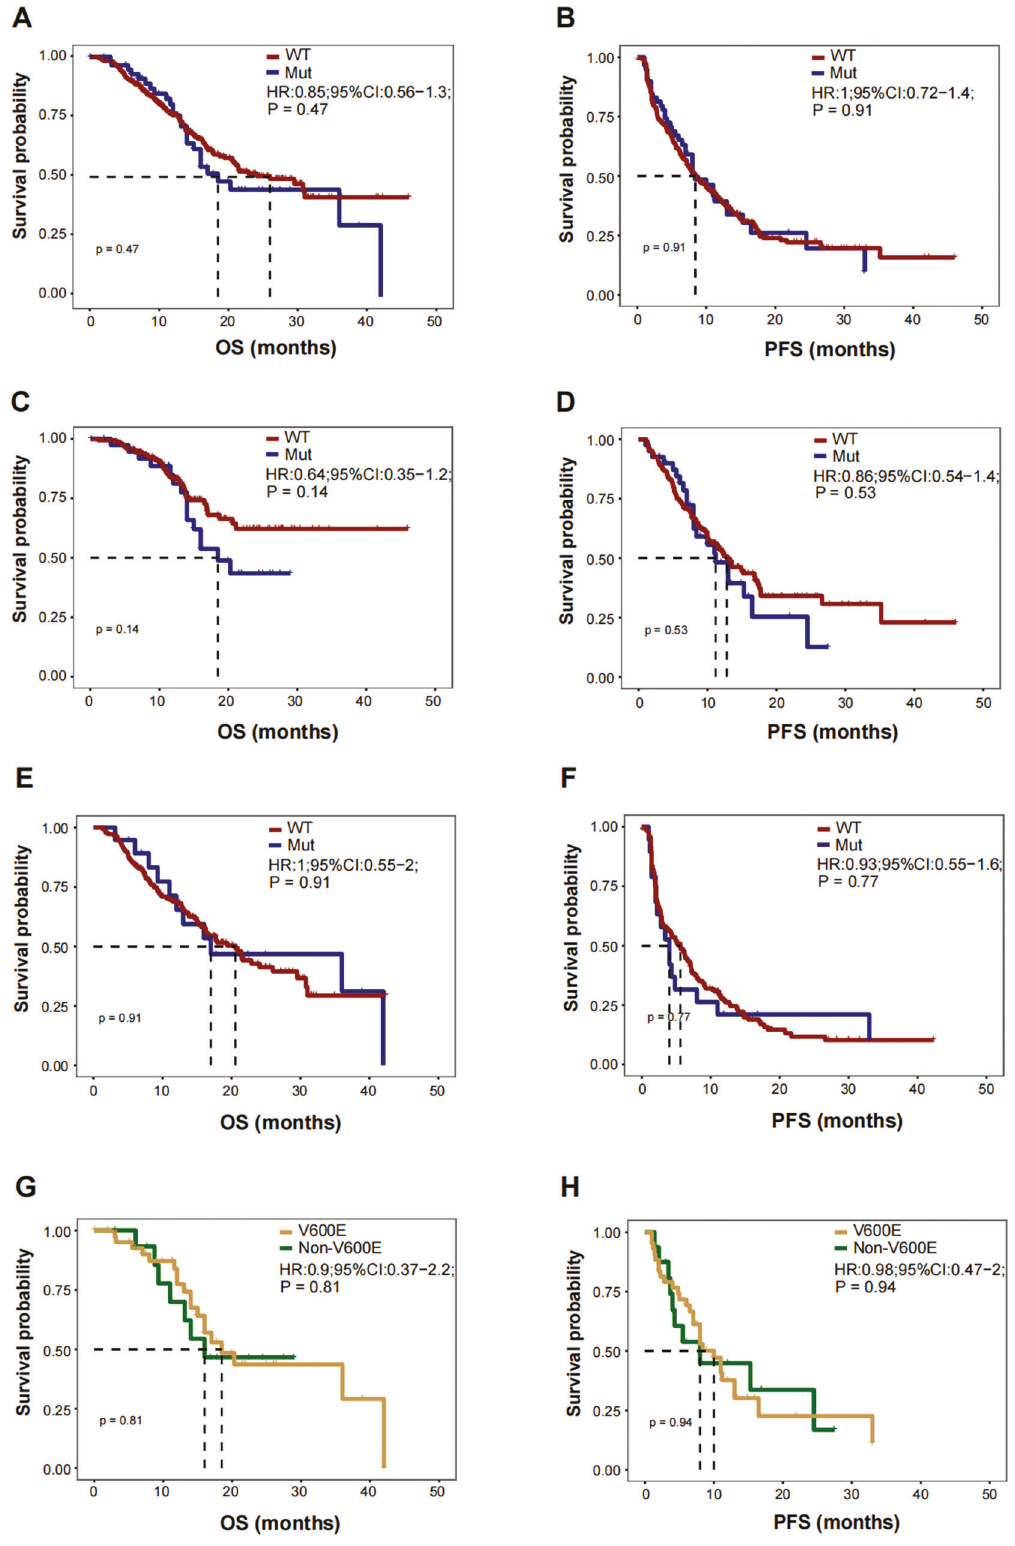
Fig. 6 Kaplan – Meier curves for progression-free survival and overall survival with ICIs monotherapy or ICIs combined therapy. A , B Overall survival ( A ) and progression-free survival ( B ) with ICIs or ICIs combined therapy according to the BRAF mutation status. C , D Overall survival ( C ) and progression-free survival ( D ) for fi rst line therapy according to the BRAF mutation status. E , F Overall survival ( E ) and progression-free survival ( F ) for second or later line therapy according to the BRAF mutation status. G , H Overall survival ( G ) and progression-free survival ( H ) with ICIs or ICIs combined therapy according to the BRAF mutation type.